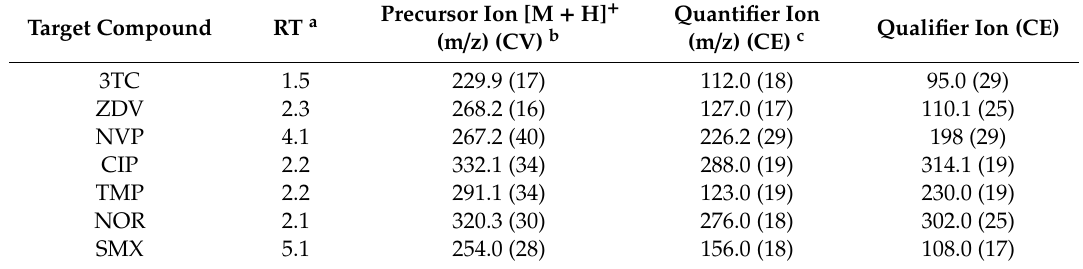
Target Compound